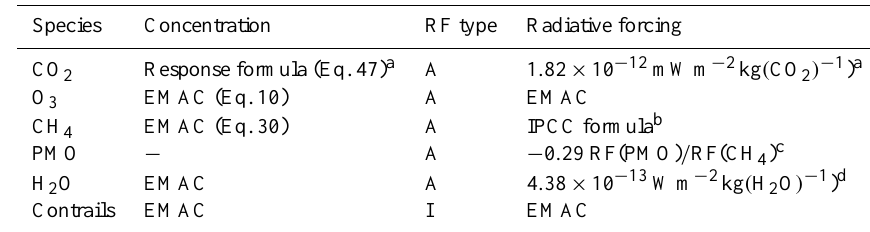
Table 6. Overview on radiative forcing calculation for various species. “A” and “I” stand for adjusted and instantaneous radiative forcing in the column “RF